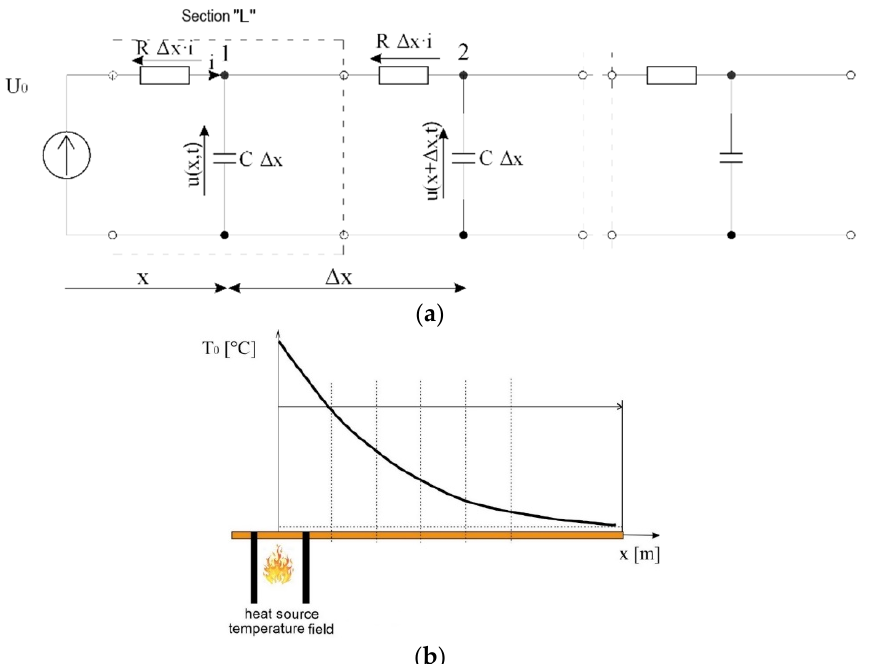
Figure 2. Sketch showing an electrical cable division ( a ) into L ‐ type quadripole sections; ( b ) into measuring sections for time t 1 .